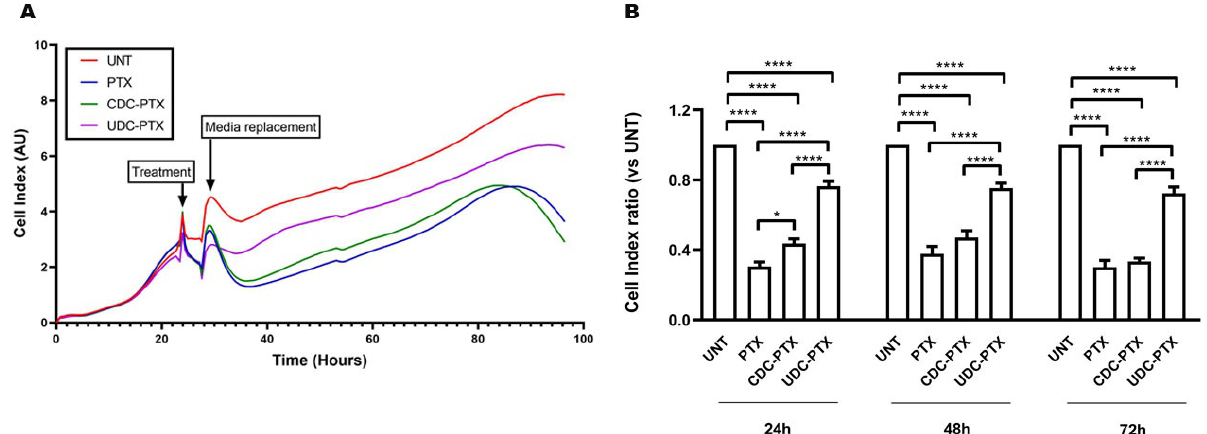
Figure 4. Time course effects of PTX and of its derivatives on HCT116 evaluated by the xCELLigence RTCA DP Instrument. ( A ) Representative graph from RTCA software reporting real time cell index. ( B ) Analysis of HCT116 cell viability after treatment with 5 μ M PTX, CDC-PTX-UDC-PTX for 4 h. Results are indicated as mean ± SEM of two replicates performed at least in quadruplicate. Statistical analyses were performed 24, 48 and 72 h after treatment with ANOVA and corrected with Bonferroni post-test. * p < 0.05; **** p < 0.0001.